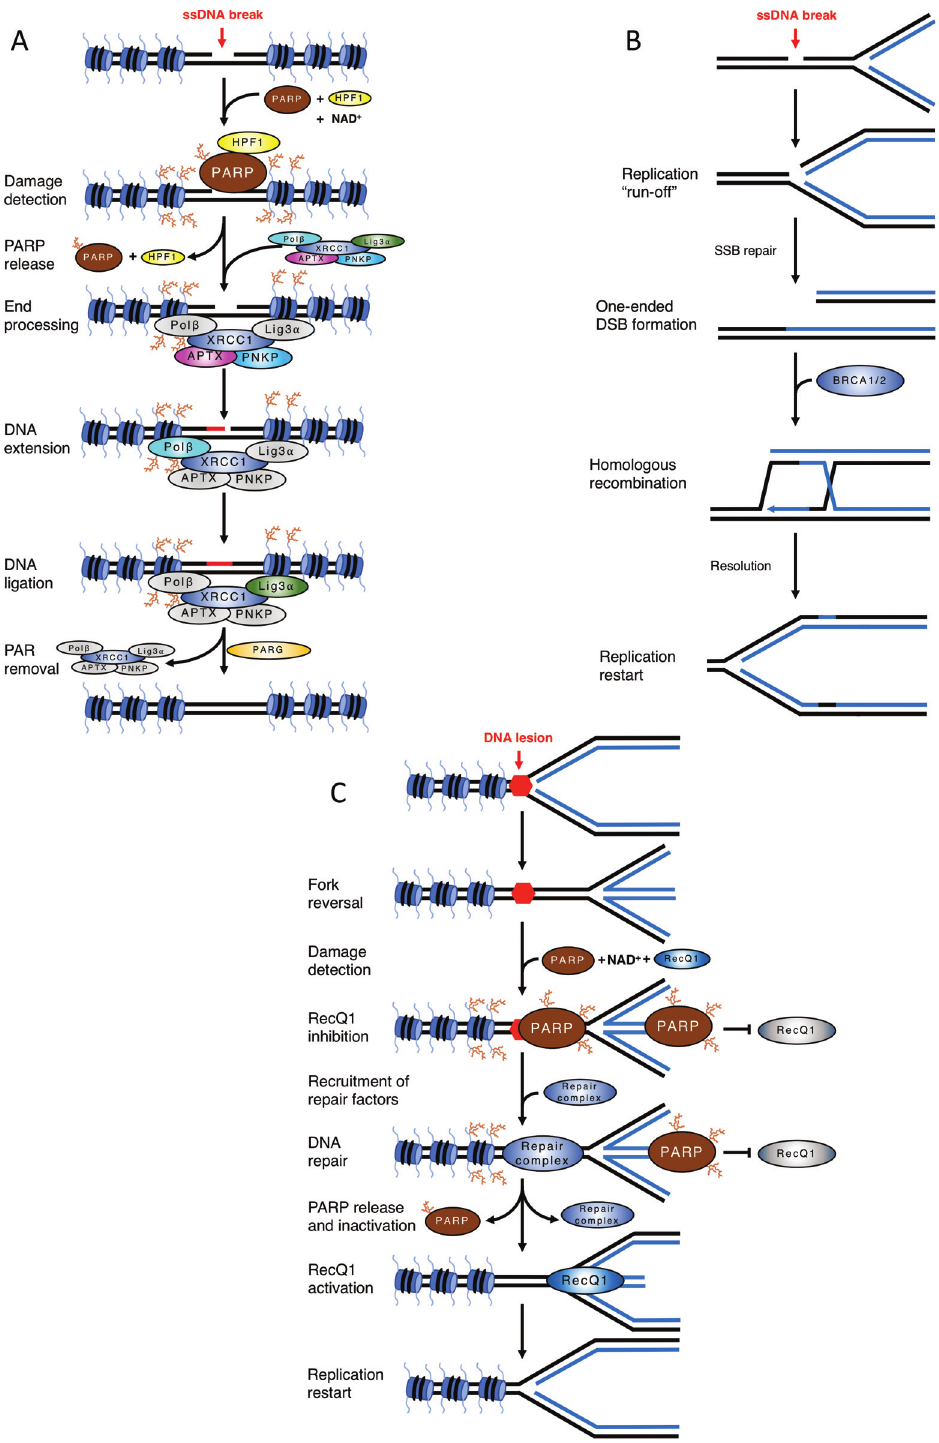
Figure 2 - Examples of the impact of ADP-ribosylation in DNA damage signalling and repair. A) Mechanism of single-strand break repair. A single- strand break activates PARP1/2, leading to HPF-1 assisted PARylation of chromatin. PARP auto-modification causes its release and PAR chains sur- rounding the break site recruit XRCC1 complex. APTX and PNKP process break termini, Pol (cid:2) fills the gap by DNA synthesis and DNA Ligase III (cid:3) seals the remaining nick. PARG removes PAR chains and XRCC1 complex is released, completing the repair. B) Defective single-strand break repair causes a reliance on homologous recombination. An unrepaired single-strand break is encountered by an ongoing replication fork, which converts it into a one-endeddouble-strandbreak.ThislesionisrepairedbyBRCA1andBRCA2-dependenthomologousrecombination.C)RoleofPARP1/2inforkrever- sal. A replication fork encounters an obstacle to its progression and reverts. PARP is activated either by the obstacle/lesion itself or by the DNA end at the regressed fork. PAR chains prevent RecQ1 binding/activity. Upon resolution of the block, PARP release (and presumably PAR chain degradation by PARG) allow RecQ1 helicase to access the reversed fork and remodel it back into a canonical replication